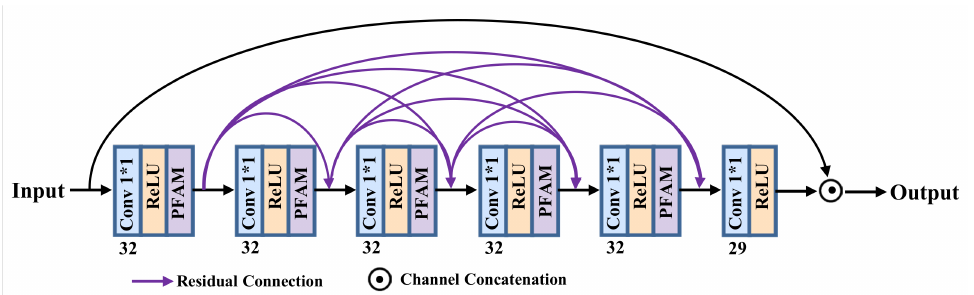
Figure 2. Specific framework of the RDA